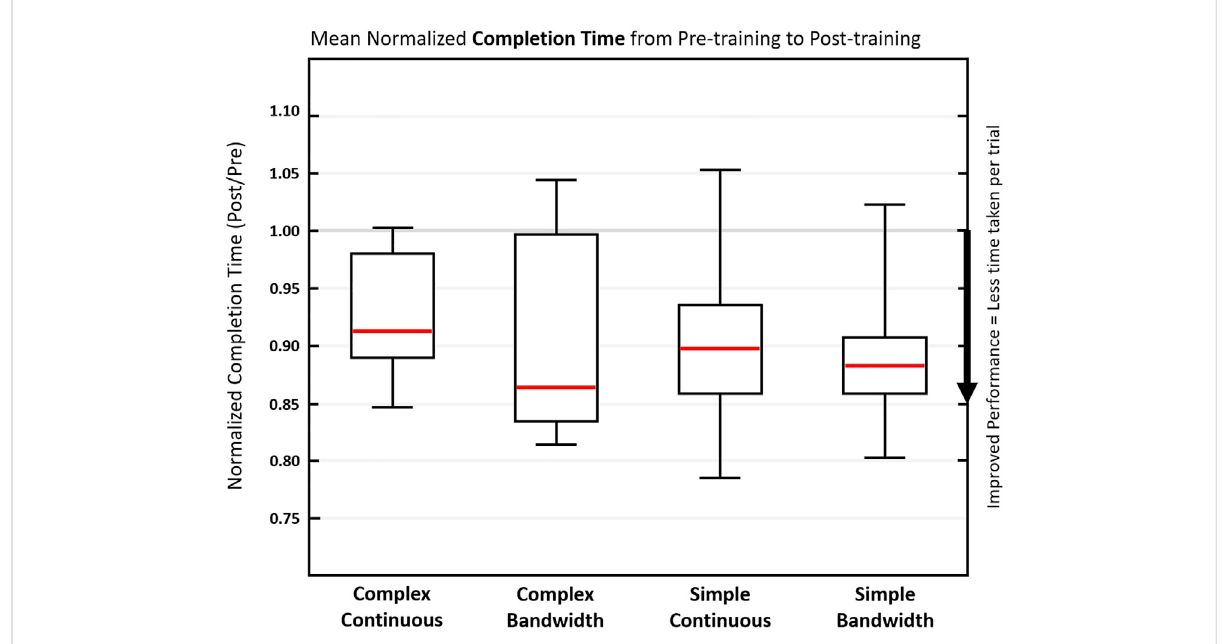
FIGURE 5 Resultsindicaterelativechangeintrialcompletiontimeperformanceaftertraining asmeantimeinpost-trainingisdivided(normalized)bytime in pre-training for each participant.